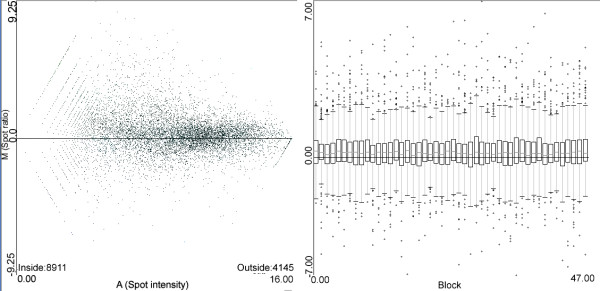
AM and boxplot graphs on one of the initial dataset. Quantized low quality values can be observed in the low intensity zone of AM graph suggesting the need for a filtering procedure, and the nice shape in the boxplot (on the right hand side) suggests that scaling procedure is unnecessary.